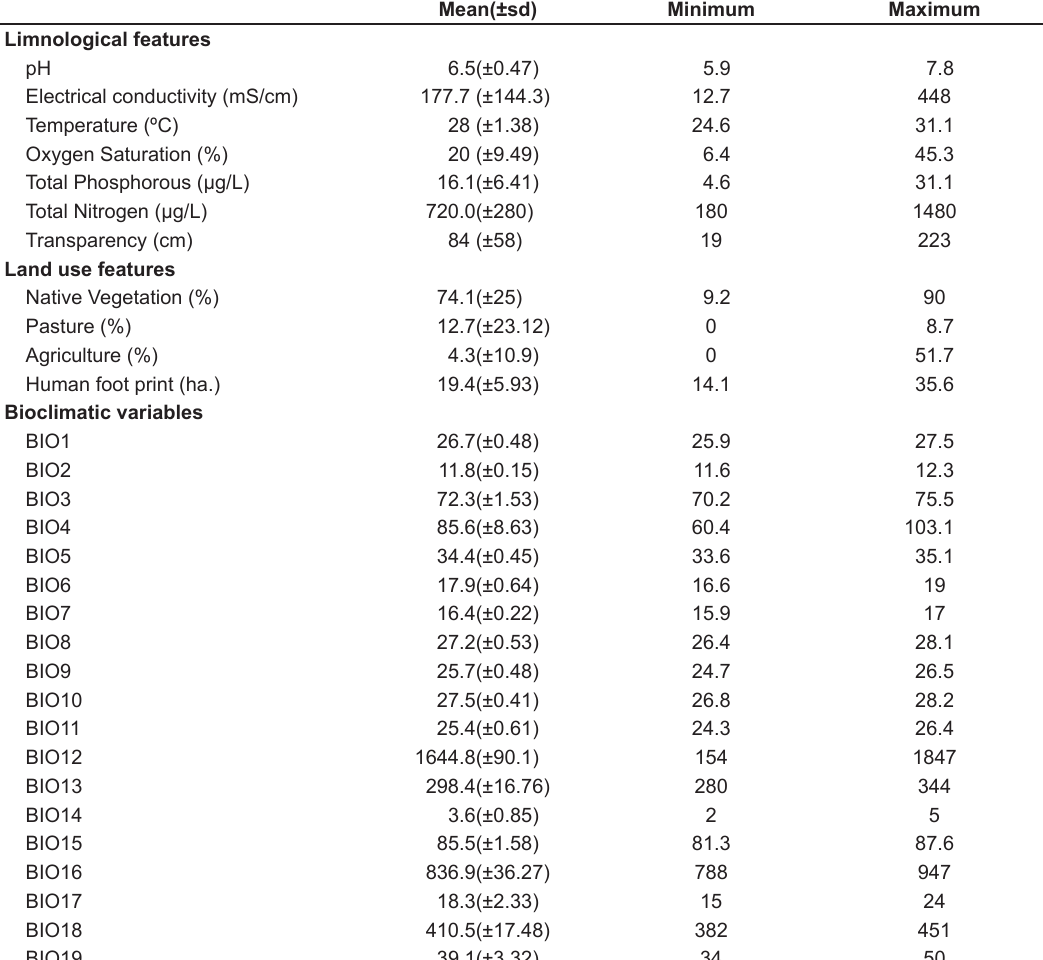
Table 1. Statistical summary for the limnological, land use and bioclimate variables of the sampled lakes.